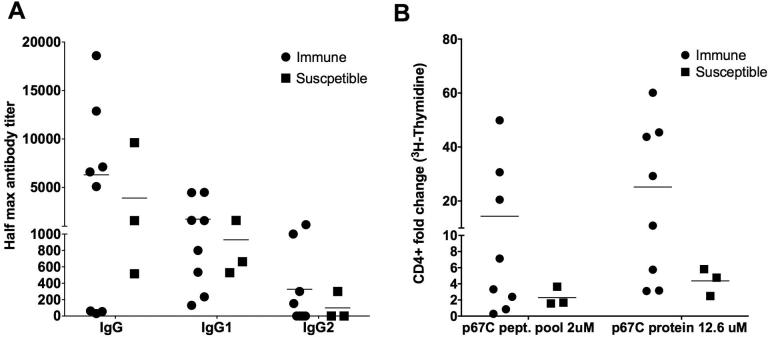
p67C specific immune responses in immune versus susceptible animals (Group 2). Group 2 (three doses) is parted in two, based on the ECF score: immune (ECF score ≤ 5.99) and susceptible (ECF score ≥ 6) for all the parameters. Animals are plotted individually and the average of each group is shown. (A) Subtype specific p67C antibody titers (IgG, IgG1 and IgG2) at the day of challenge (day 77), measured by ELISA and (B) p67C specific CD4+ T-cell proliferation index, one week prior challenge (day 70), measured by means of a 3H-thymidine based CD4+ proliferation assay in immune versus susceptible animals.